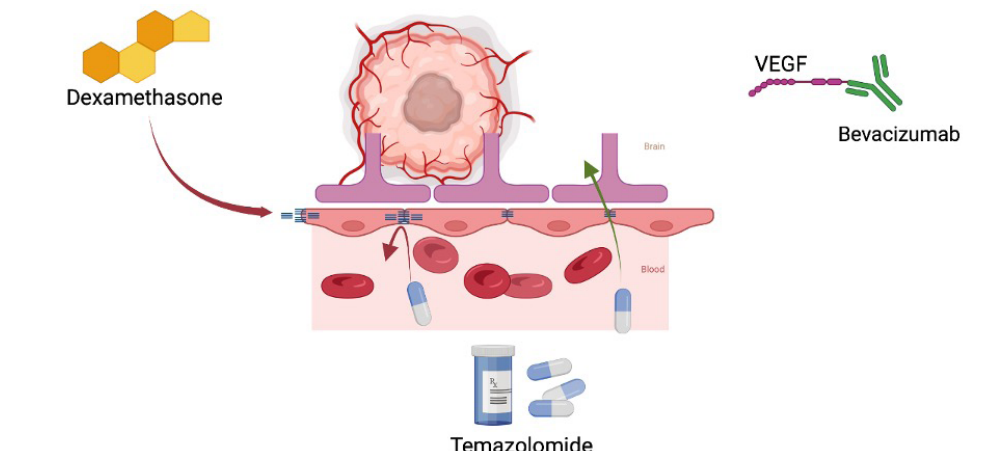
Figure 1. Immunosuppresent effects on the tumor microenvironment. This figure illustrates how dexamethasone upregulates tight junctions of the BBB which may alter pharmacokinetics. It also shows hyperglycemia induced by steroids fueling oncologic anaerobic metabolism. VEGF: vascular endothelial growth factor